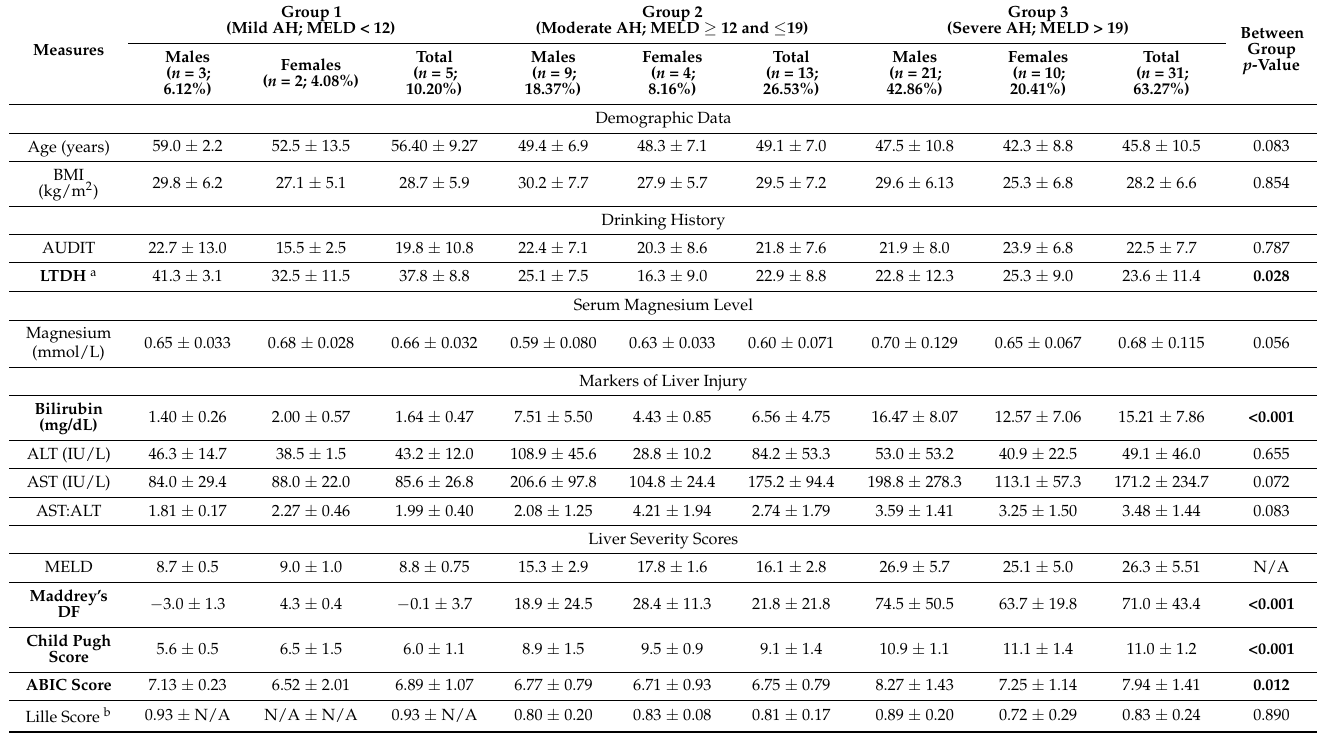
Table 1. Demographic, drinking, liver injury and severity markers in AH patients grouped by the categorical ranking of MELD score. Statistical significance was set at p < 0.05. Significant measures are in bold. Data are presented as the mean ± standard